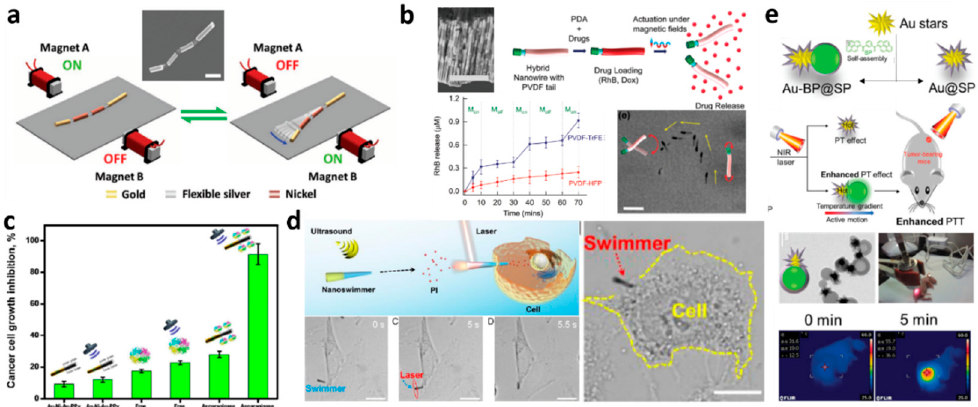
Figure 2. Summarizes selected examples of external field driven nano- and micromotors: ( a ) Magnetic propulsion of an artificial nanofish using a planar oscillating magnetic field, inset: SEM image of a multilinked artificial nanofish made by electrodeposition. Scale bar: 800 nm. Reprinted from [115] with permission from John Wiley and Sons, Copyright 2016. ( b ) SEM image showing alternating Ni–Au nano-ring segments grown around PPy NWs, Scale bar 4 µ m, Time-lapse showing a single hybrid nanoeel transition from a surface-walking swimming mode to a wobbling motion upon changing the parameters of magnetic fields. Scale bars: 15 µ m. Controlled drug delivery with the hybrid nanoeels starting from functionalization with PDA and drugs, followed by magnetically triggered drug release and pulsatile release of RhB with and without magnetic fields ( n = 6), Reprinted from [43] with permission from John Wiley and Sons, Copyright 2019. ( c ) Cancer growth inhibitory e ff ects of free and immobilized asparaginase compared to di ff erent control experiments, error bars show the standard deviation of 3 measurements ( n = 3). Reprinted with permission from [137] Copyright RSC 2017. ( d ) NIR light-assisted cell poration. Schematic cell poration of the AuNS-functionalized (PSS / PAH) nanoswimmers upon the exposure of NIR light. Time lapse showing the movement of the nanoswimmers toward HeLa cell under the acoustic field and the perforation with NIR irradiation. Scale bars, 10 µ m. Blue dash line shows the trajectory of acoustic driving and red circle indicates the region of laser spot. CLSM image of the nanoswimmers after cell poration. Yellow dash line indicates the frontier of the cell. Scale bar, 10 µ m. Adapted with permission from [111]. Copyright (2019) American Chemical Society. ( e ) Schematic illustration of a self-propulsion Au-BP@SP Janus nanoparticle for cancer cell treatment under NIR laser irradiation. TEM images characterizing AuBP@ SP Janus nanohybrid. The Infrared thermal images of Au@SP and Au-BP7@SP injected MCF-7 tumor-bearing mice at di ff erent time points under laser irradiation at 808 nm. Reprinted from [142] with permission from John Wiley and Sons, Copyright